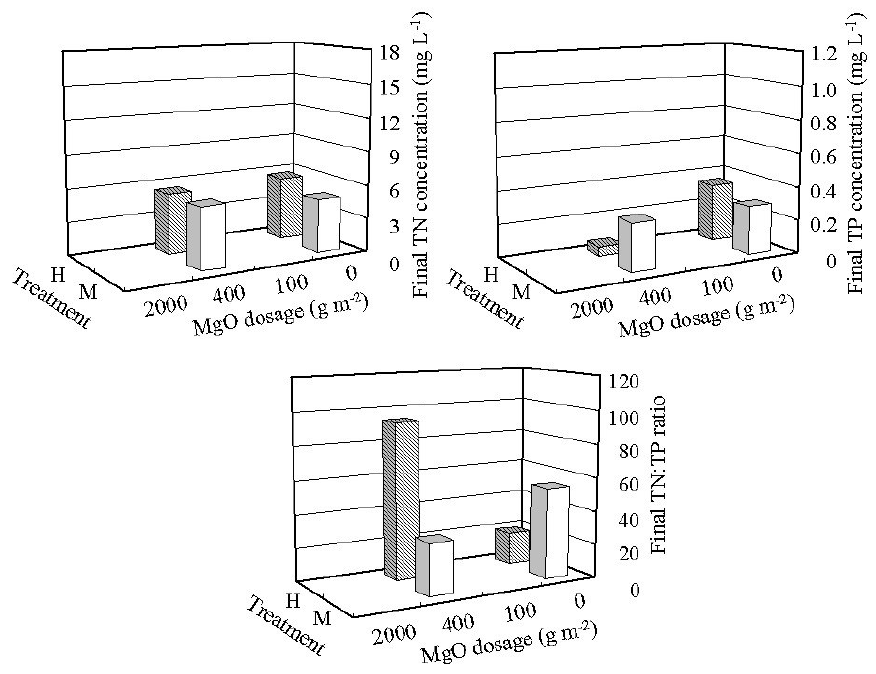
FIGURE 4. Changes in the final TN and TP concentrations, and the TN:TP ratios through the nutrient elusion test (mesocosm). N, nontreated sediment; M, MgO-treated sediment; D, DAF-treated sediment; H, hybrid-treated